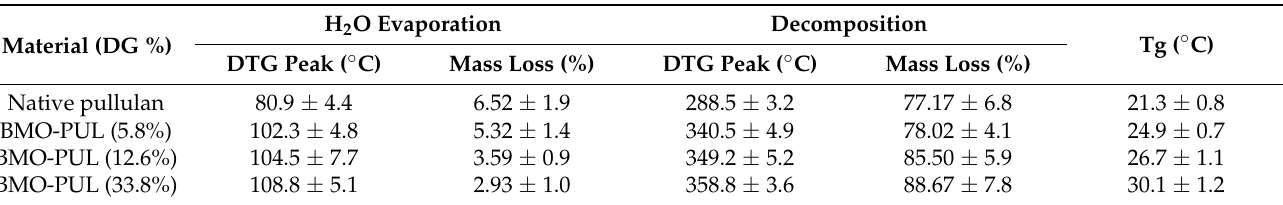
Table 1. A summary of the thermal analysis results for BMO-PUL derivatives with different degrees of substitution ( n = 3; ± SD).